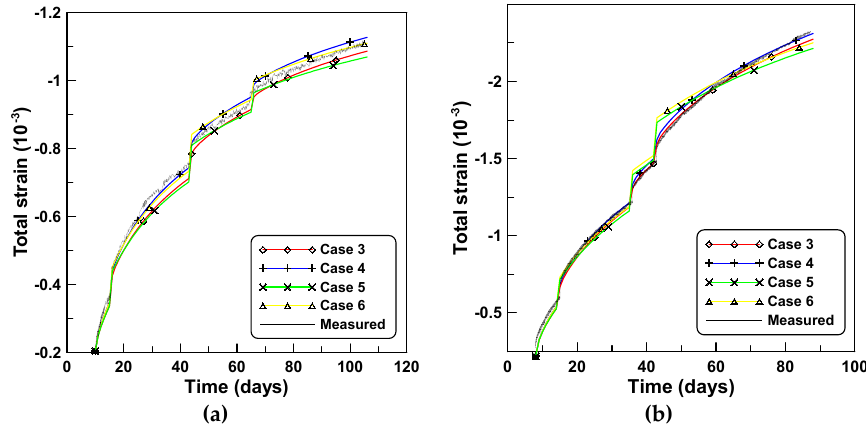
Figure 4. Total strains obtained by different creep models under stepwise loads: ( a ) test series A and ( b ) test series B.